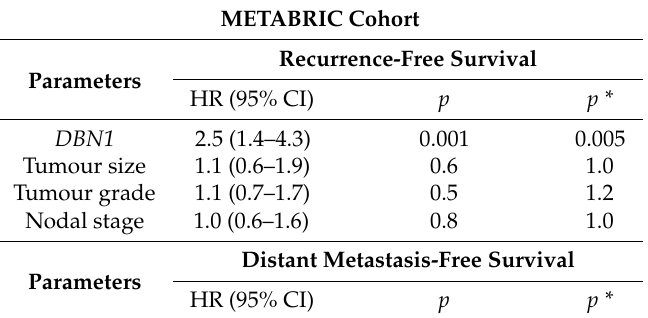
Distant Metastasis-Free